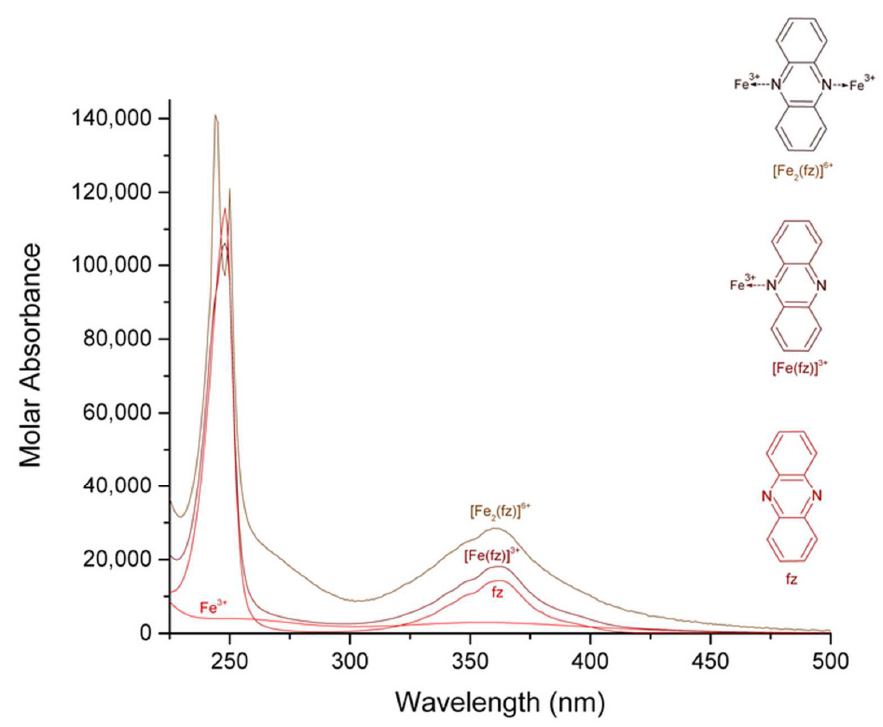
Figure 3. Calculated electronic spectrum of the solution system iron (III)-phenazine in methanol: Fe 3+ , [Fe (fz)] 3+ , [Fe 2 (fz)] 6+ , and fz.